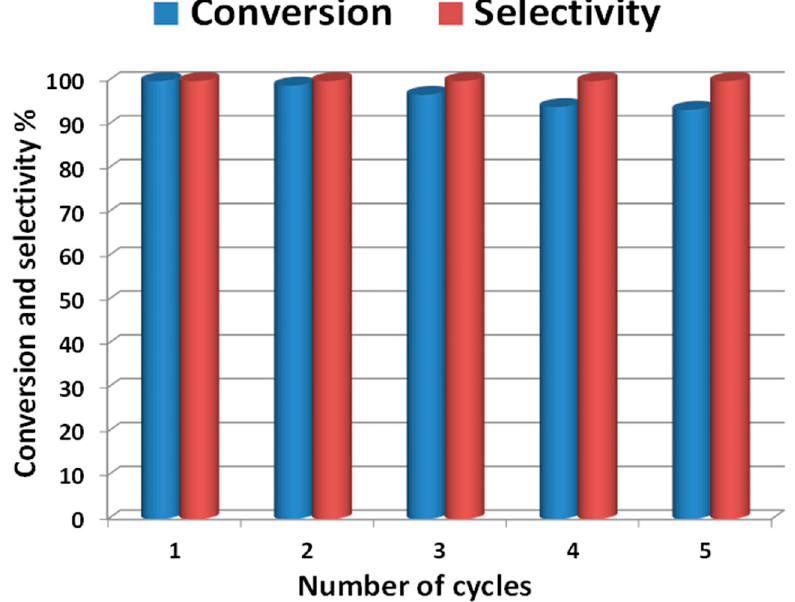
Figure 10. The recyclability ZnO x (1%)–MnCO 3 /(1%)HRG catalyst in the selective oxidation of benzyl alcohol. (Reaction conditions: catalyst, 0.3 g; benzyl alcohol, 2 mmol; calcination temperature, 300 °C; reaction temperature, 100 °C; oxygen flow rate, 20 mL ∙ min − 1 ; toluene, 10 mL; and 7 min reaction time).